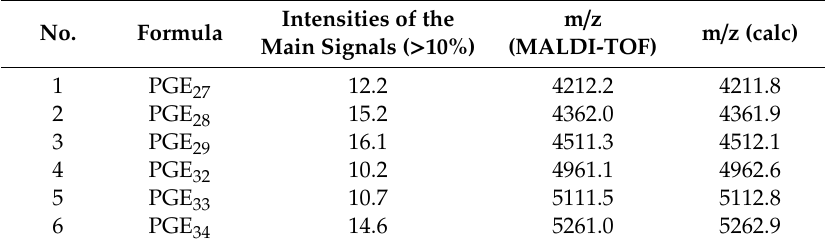
Table 13. PPGE-diols accompanied AGE / PGE copolymerization initiated with K-DPG /